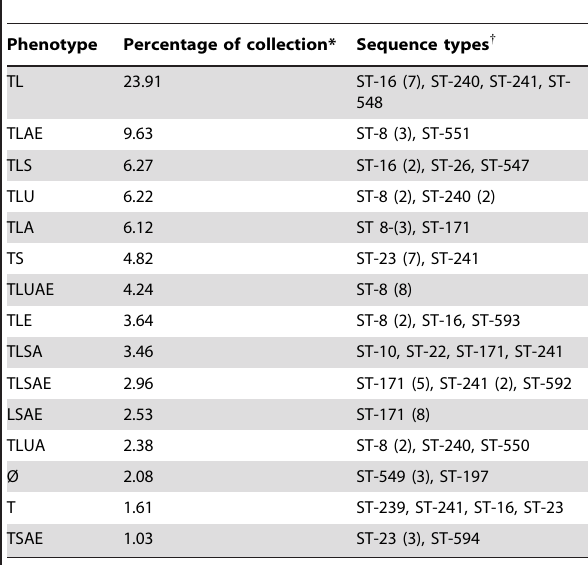
*Percentage of the phenotype among 3,639 characterized isolates. { Values in parentheses represent the number of isolates found (if more